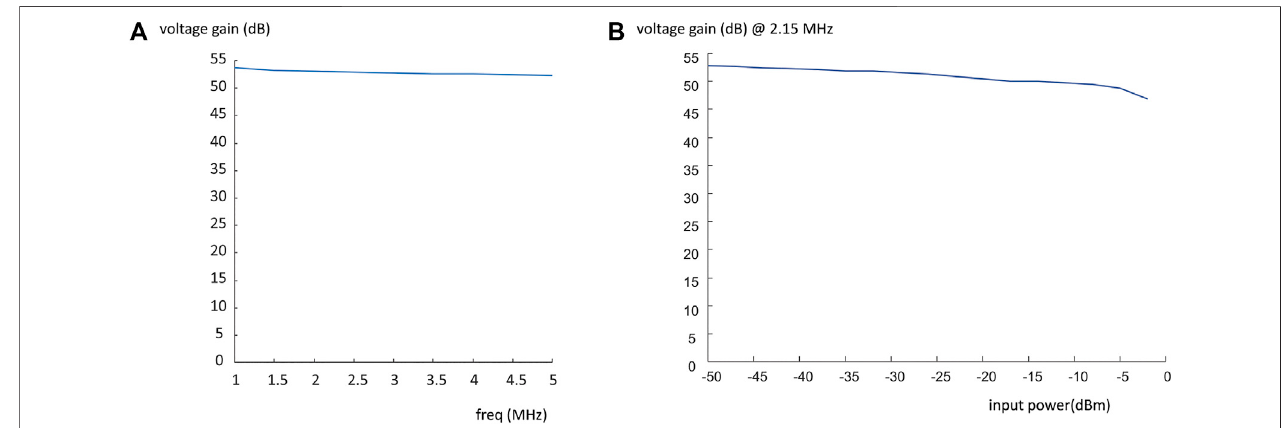
FIGURE 10 | Plot of voltage gain vs. frequency (A) , and the voltage gain at the operating frequency of 2.15 MHz vs. input power from the Kea spectrometer (B) .